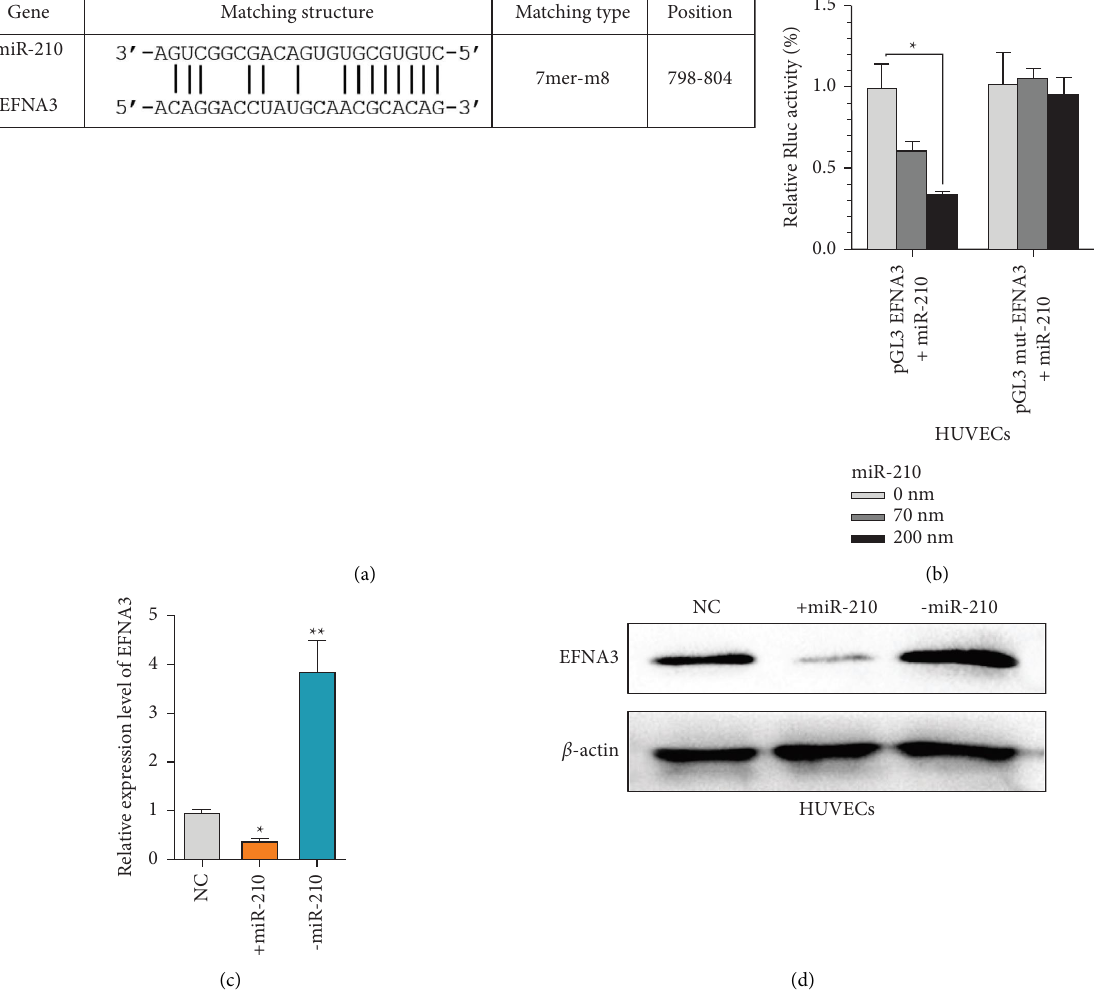
Figure 4: miR-210 regulates EFNA3 expression. (a) Te prediction for miR-210 binding sites on the EFNA3 transcript. (b) Luciferase activity in HUVECs cotransfected with the indicated miR-210 concentration or EFNA3 luciferase reporter transcript. Data are shown as the ratio of frefy activity to Renilla luciferase activity. (c) Relative EFNA3 expression in the indicated HUVECs was measured by qRT-PCR. (d) Relative EFNA3 protein expression in the indicated HUVECs was measured by WB